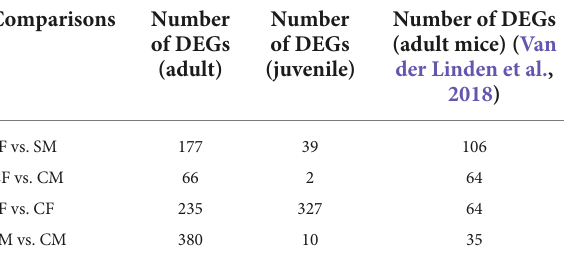
TABLE 1 Total differentially expressed genes among the specific experimental conditions in the VNO of adult and juvenile rabbits and its comparison with previous data in mice VNO (Van der Linden et al.,